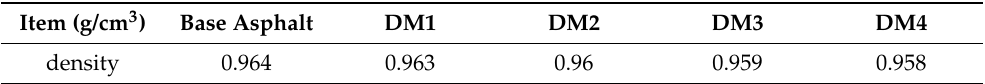
Table 3. Density of asphalt model (298